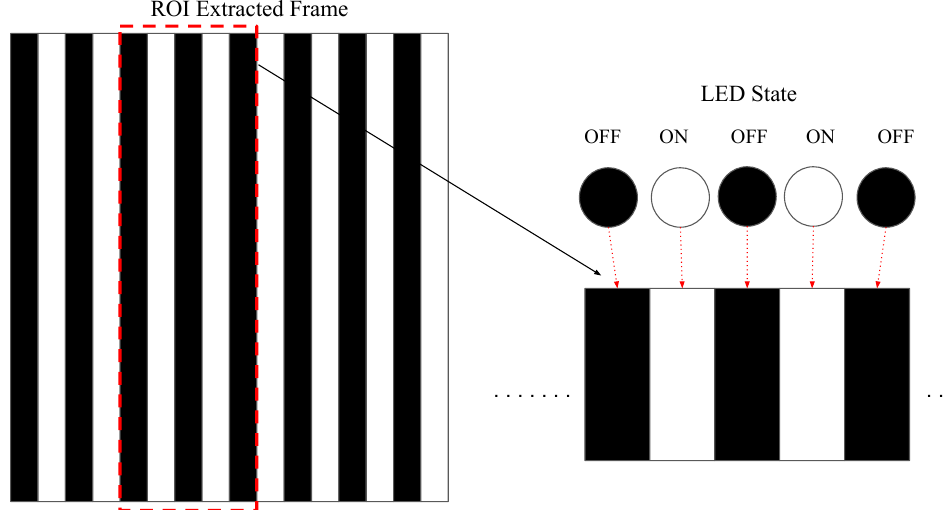
Figure 4. Rolling Shutter